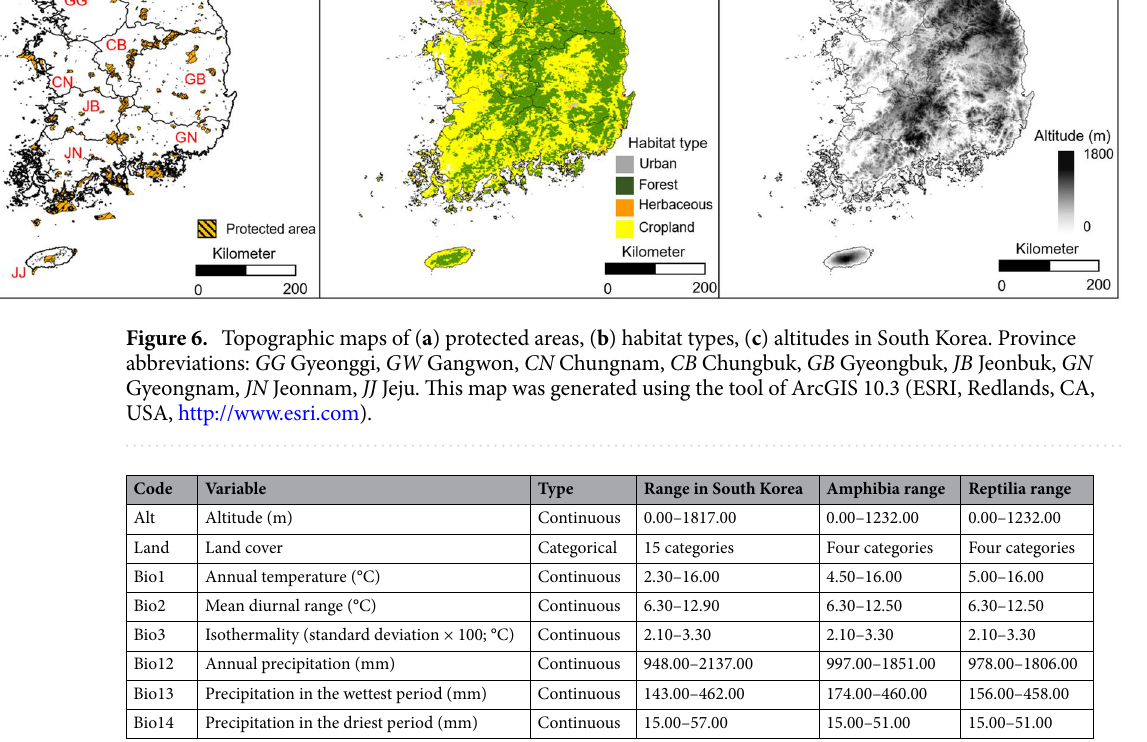
Table 3. Environmental variables used for Maxent modeling the distribution of the 19 amphibian and 20 reptile species in South Korea. Data 39 (http:// www. world clim. com).